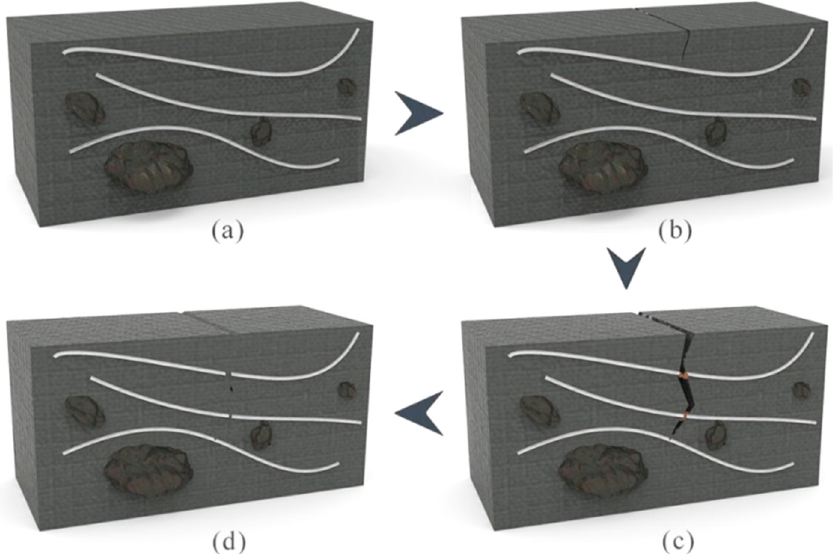
Figure 8. Illustration of the process of microvasculars rejuvenating asphalt, ( a ) an asphalt sample with multi-microvasculars, ( b ) microcrack triggered, ( c ) tip-stress of a microcrack pierced the microvasculars, and ( d ) rejuvenator in microvasculars released out.